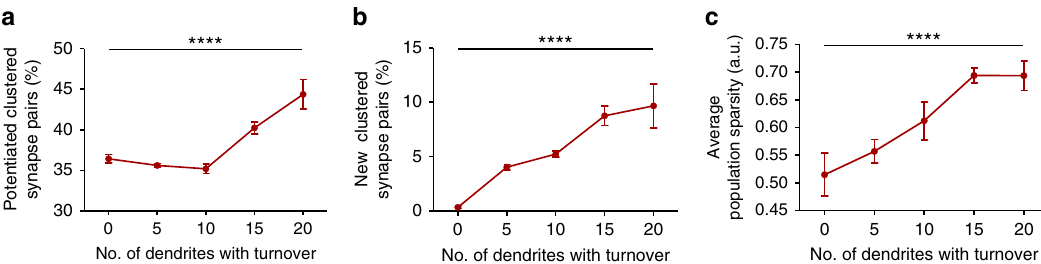
Fig. 4 Spine turnover in fl uences clustering and network functions in a computational model. a Increasing the number of dendritic branches that undergo high synaptic turnover increases the incidence of potentiated clustered synapse pairs (two synapses within 0.2 a.u.) ( n = 10 simulation trials; F (4,45) = 16.69, p < 0.0001; m = 2.05, r 2 = 0.41, p < 0.0001). Clusters were evaluated after 4 repeated learning episodes spaced 24 h apart. b Increasing the number of dendritic branches with turnover increases the percentage of new synapse pairs that occur in clusters ( n = 10 simulation trials; F (4,45) = 14.19, p < 0.0001; m = 2.34, r 2 = 0.54, p < 0.0001). Synapses were considered as new if they emerged after day 1 of simulated training. c Increasing the number of dendritic branches with turnover increases the average neural population sparsity of 10 memory engrams which are serially encoded in the same circuit, 24 h apart ( n = 10 memory engrams; F (4,45) = 7.96, p < 0.0001; m = 0.05, r 2 = 0.39, p < 0.0001). Sparsity was assessed by the Treves-Rolls sparsity metric. Data are represented as mean ± s.e.m. Second reported p- value is from the post test for linear trend following one-way ANOVA. **** p